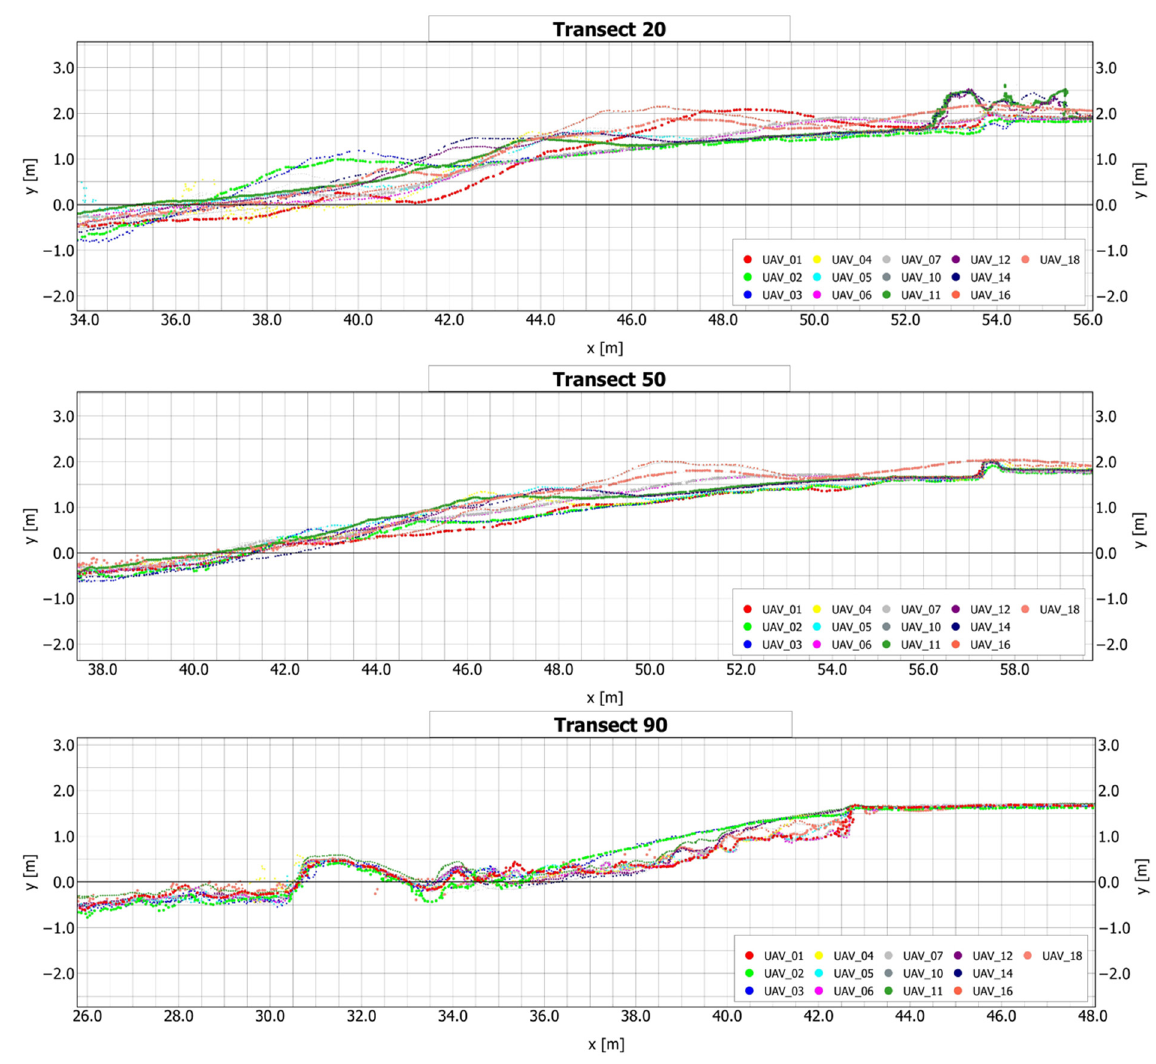
Figure 11. Elevation changes in transects at the west ( top ), in the middle ( middle ) and at the east end of the beach ( bottom ).